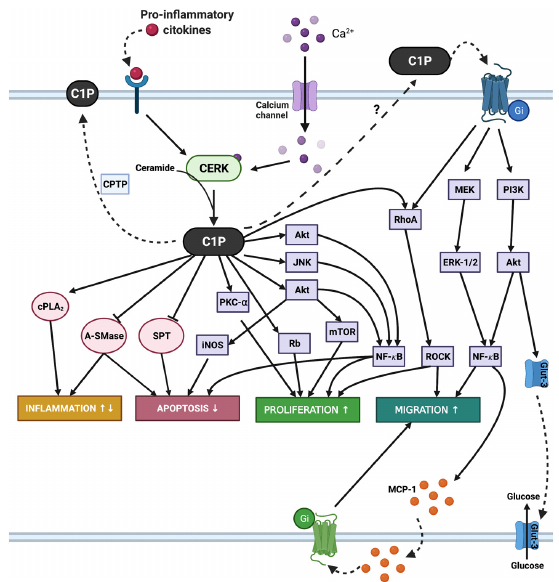
Figure 3. C1P biology in tumorigenesis. C1P is generated intracellularly by CERK, an enzyme dependent upon calcium ions for activity. C1P can be transported to the plasma membrane by CPTP or can be secreted into the extracellular environment. Intracellular C1P can exert various biological functions, including stimulation of cell growth, inhibition of apoptosis, stimulation of cell migration, or modulation of inflammation, for which it targets different signaling pathways. C1P can also act extracellularly to promote cell migration or glucose uptake, through interaction with a putative Gi protein-coupled receptor, also affecting various signaling pathways, as indicated. Author Contributions: Conceptualization, A.G.-M.; writing—original draft preparation, A.G.-M., A.O., L.C., A.G.-L., and A.C.; writing—review and editing, A.O., L.C., A.G.-L. and A.C.; funding acquisition, A.G.-M. and A.C. All authors have read and agreed to the published version of the manuscript. Funding: Work in AGM lab is supported by ‘Departamento de Educación, Universidades e Investigación del Gobierno Vasco’, Basque Country, Spain (Grant IT1106-16). The work of A. Carracedo is supported by the Basque Department of Industry, Tourism and Trade (Elkartek), the Department of Education (IKERTALDE IT1106-16) and Health (RIS3), the MICINN (PID2019- 108787RB-I00 (FEDER/EU), Severo Ochoa Excellence Accreditation SEV-2016-0644, Excellence Networks RED2018-102769-T), the AECC (GCTRA18006CARR), La Caixa Foundation (ID 100010434), under the agreement LCF/PR/HR17/, and the European Research Council (Consolidator Grant 819242). CIBERONC was co-funded with FEDER funds and funded by ISCIII. Acknowledgments: Figures 1–3 were made with BioRender.com software. Conflicts of Interest: The authors declare no conflict of interest.